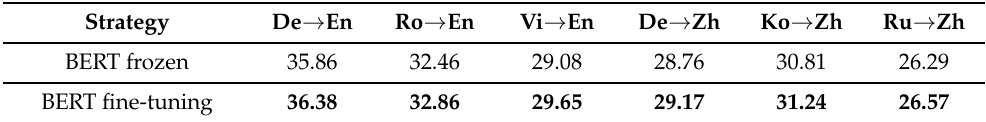
Table 6. The effectiveness of the BERT